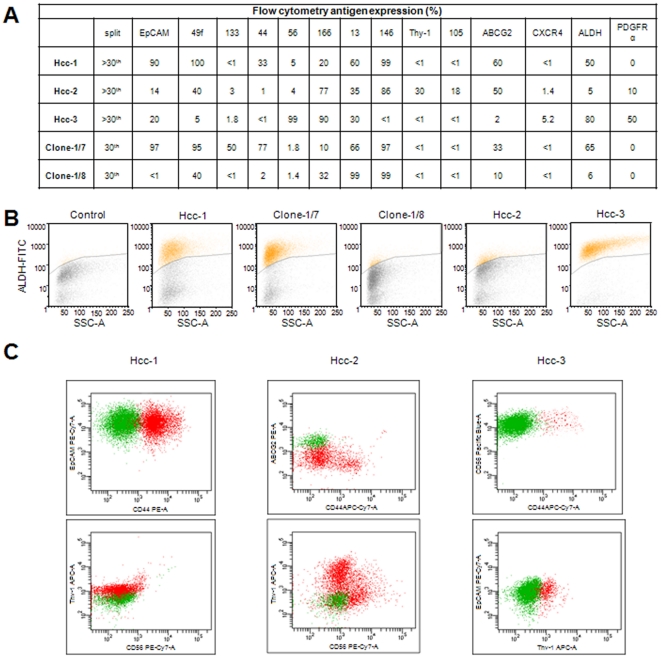
Flow cytometry characterisation of the HCC cell populations and clones in terms of the expression of the principal stem cell, epithelial and mesenchymal markers.A) Marker expression in the cell populations and clones, expressed as percentages of positive cells. B) ALDH expression in the cell populations and clones. C) Co-expression of the principal stem cell markers on ALDH positive (green dots) and negative (red dots) cells; hcc-1 left panels, hcc-2 middle panels and hcc-3 right panels, respectively.